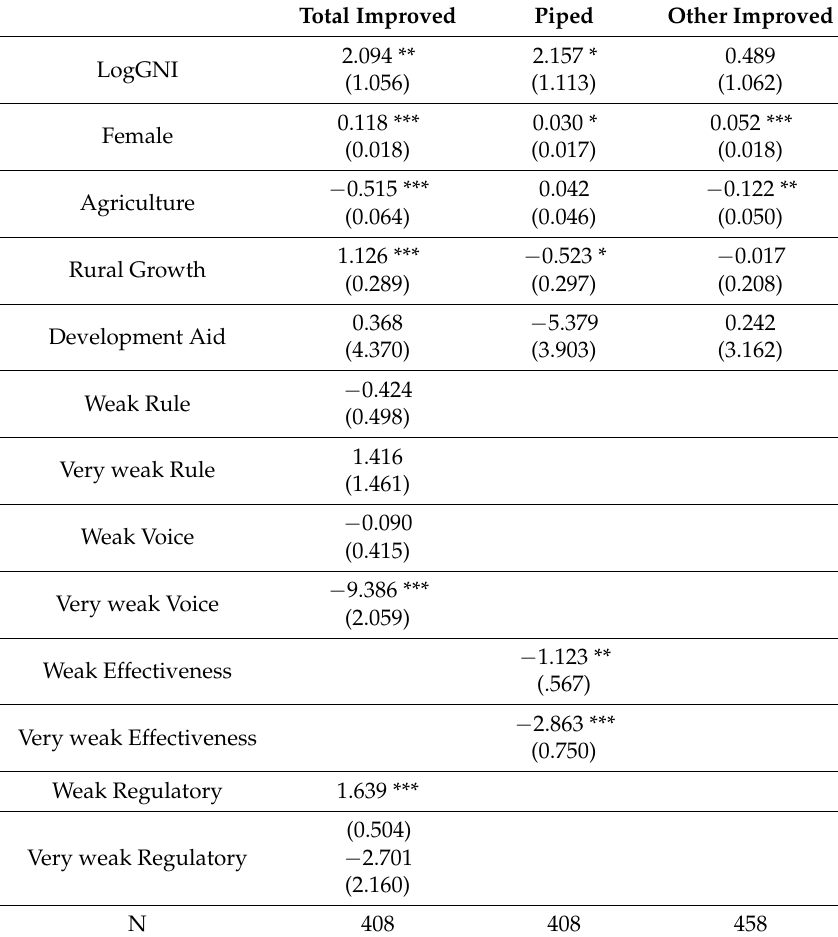
Table 6. Socioeconomic indicators. Middle-low income